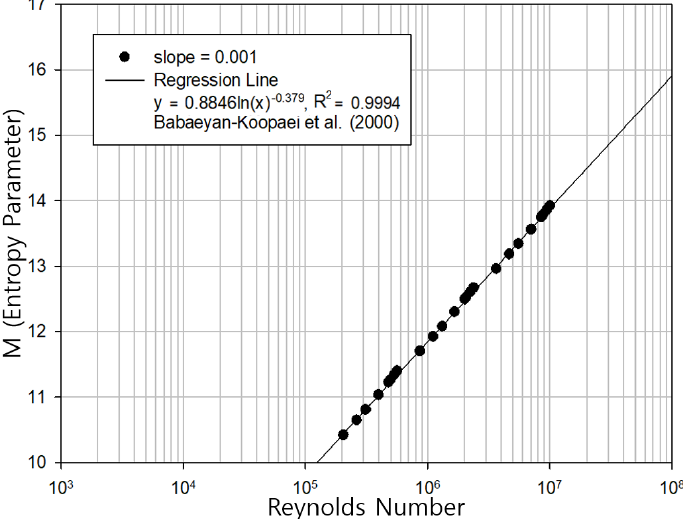
Figure 4. Relationship between M and Re calculated using Babaeyan-Koopaei’s data.